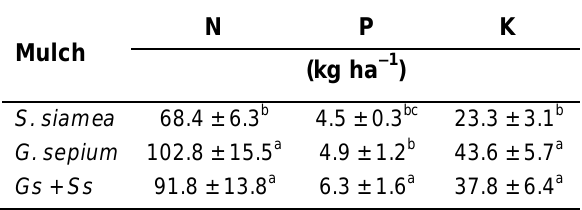
Total N, P, and K Contributed to the Soil by the Applied Mulch N Mulch